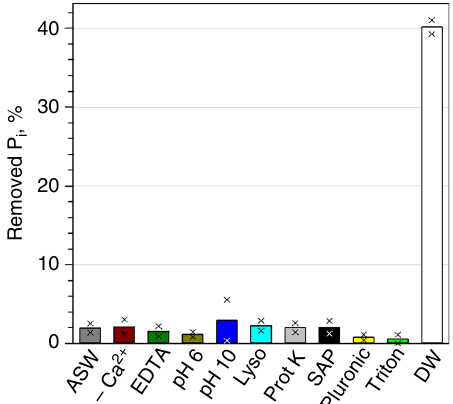
The yellow-green (505/515 nm) 0.5 μ m beads (circled in dark blue) and